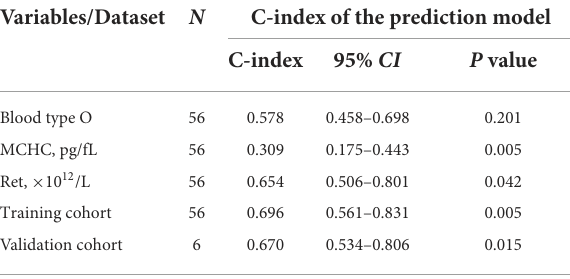
TABLE 4 C-index of the nomogram prediction